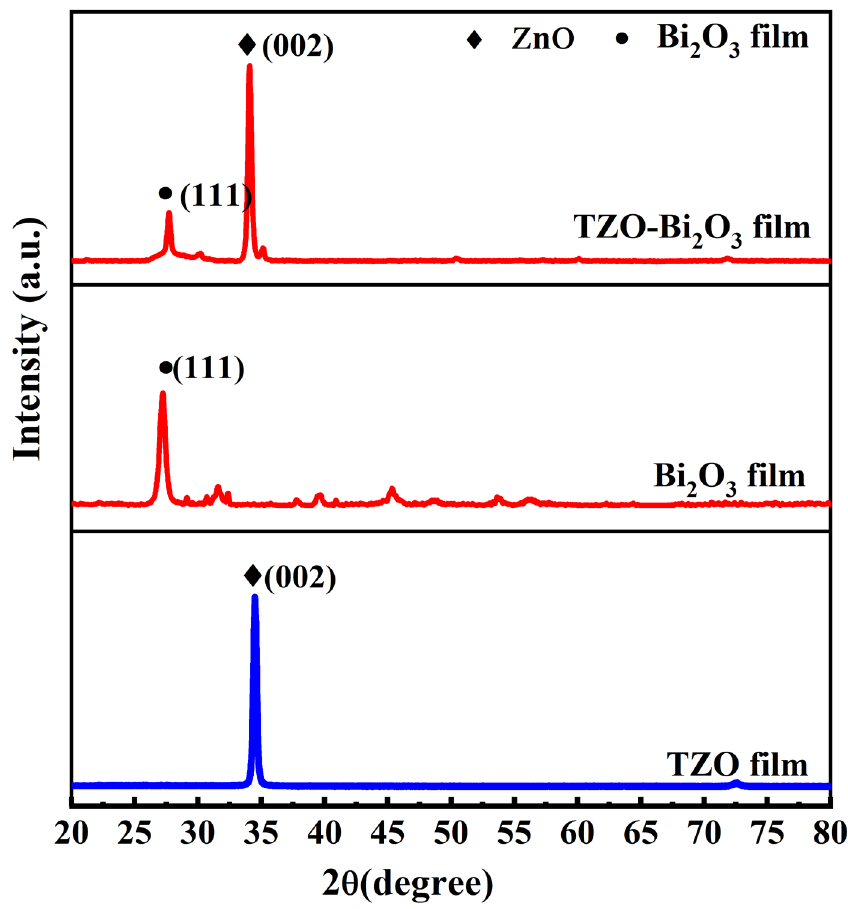
Figure 4. XRD analysis for each layer of TZO/Bi 2 O 3 heterojunction film.